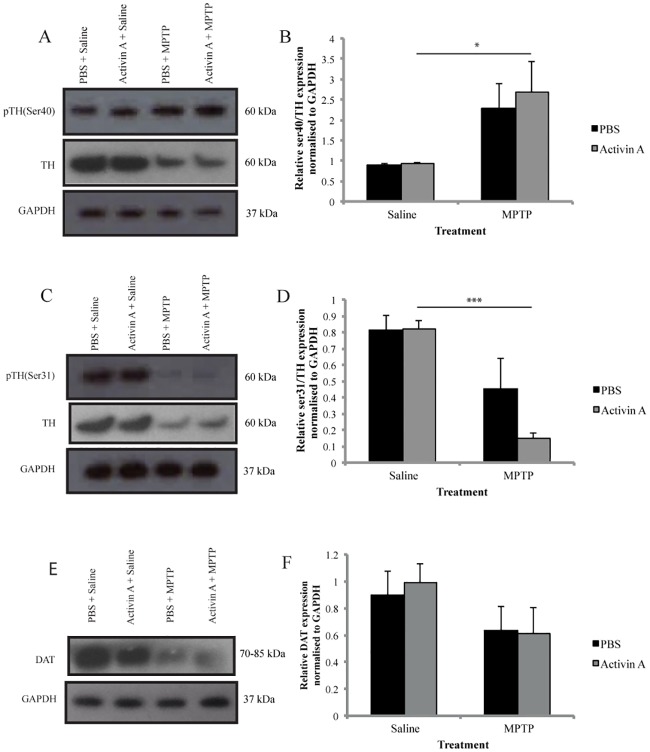
Activin A alters TH phosphorylation but not striatal DAT following MPTP.Western blot analysis of striatal protein extracts from animals receiving PBS or activin A 8 days after MPTP. Representative bands of TH, GAPDH and (A) p-TH(ser40) and (C) p-TH(ser31) expression. Quantification of p-TH(ser40)/TH (B) and p-TH(ser31)/TH (D) protein expression normalized to GAPDH (n = 6/group). (E) Representative bands of DAT and GAPDH expression. (F) Quantification of DAT protein expression normalized to GAPDH. All values represent the mean ± SEM. *p<0.05, ***p<0.001. N = 6-7/group.